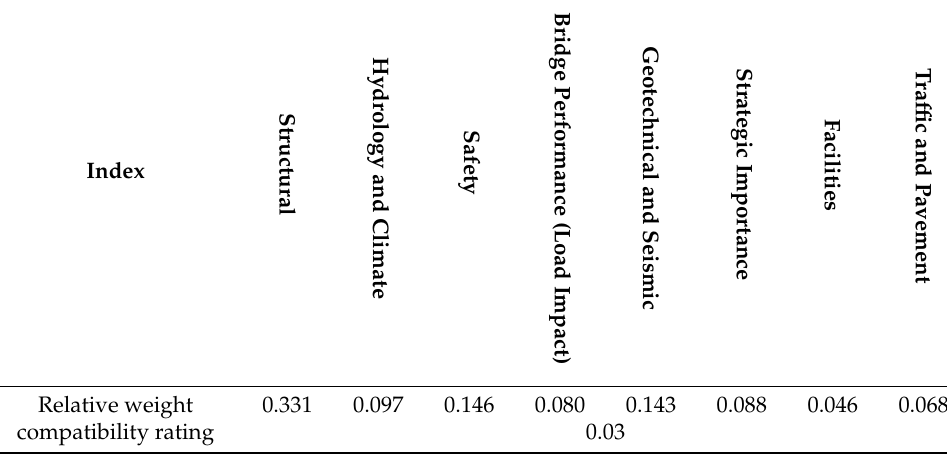
Table 7. Relative weights of indices and compatibility